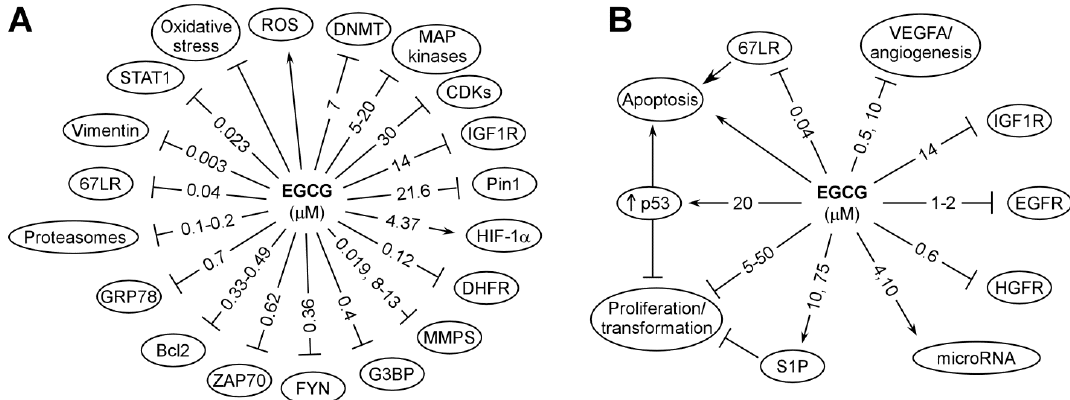
Figure 2. Possible targets for the cancer preventive activity of EGCG ( A ) and subsequent cellular events ( B ). Some of these are direct binding targets; others are affected indirectly. The reported effective concentrations, in IC 50 , K i (inhibition constant) or K d (dissociation constant) are shown in μ M. All these are from studies in vitro. When two values are given, the first value is from cell-free systems and the second value is from studies in cell lines (modified from [3]).